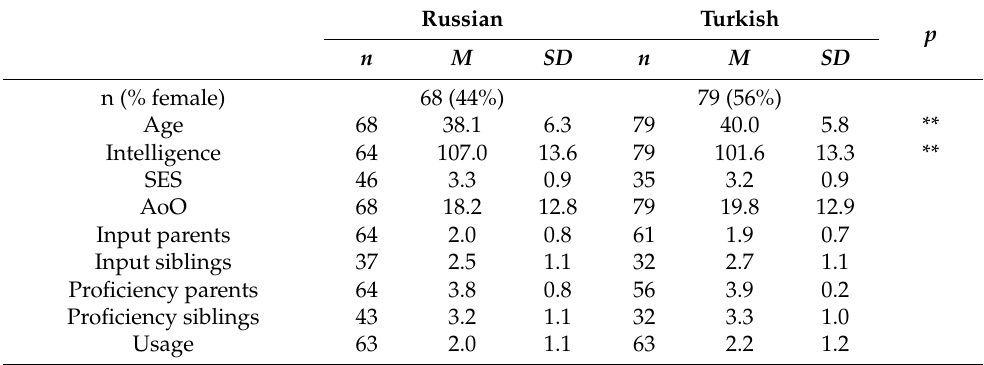
Table 1. Demographic information at pre-test and heritage language (HL) input and